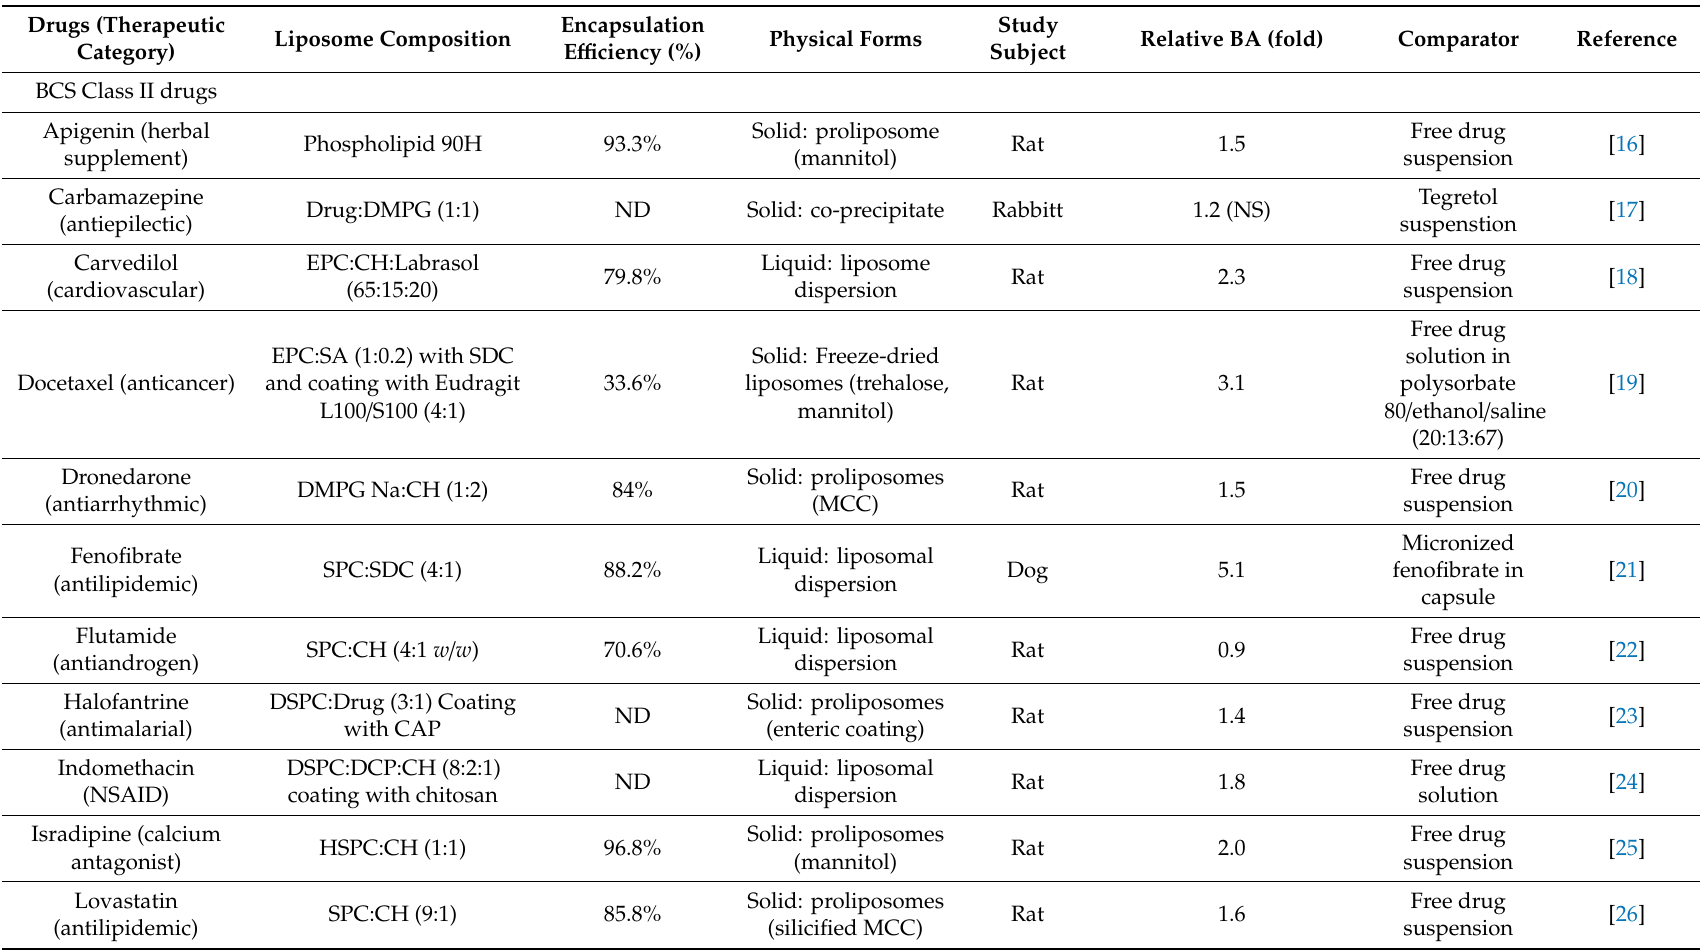
Table 1. Characteristics and in vivo bioavailability of liposomal formulations for various water-insoluble